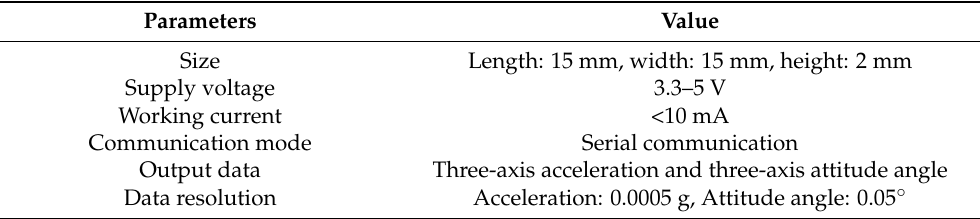
Table 1. Technical parameters of attitude sensor